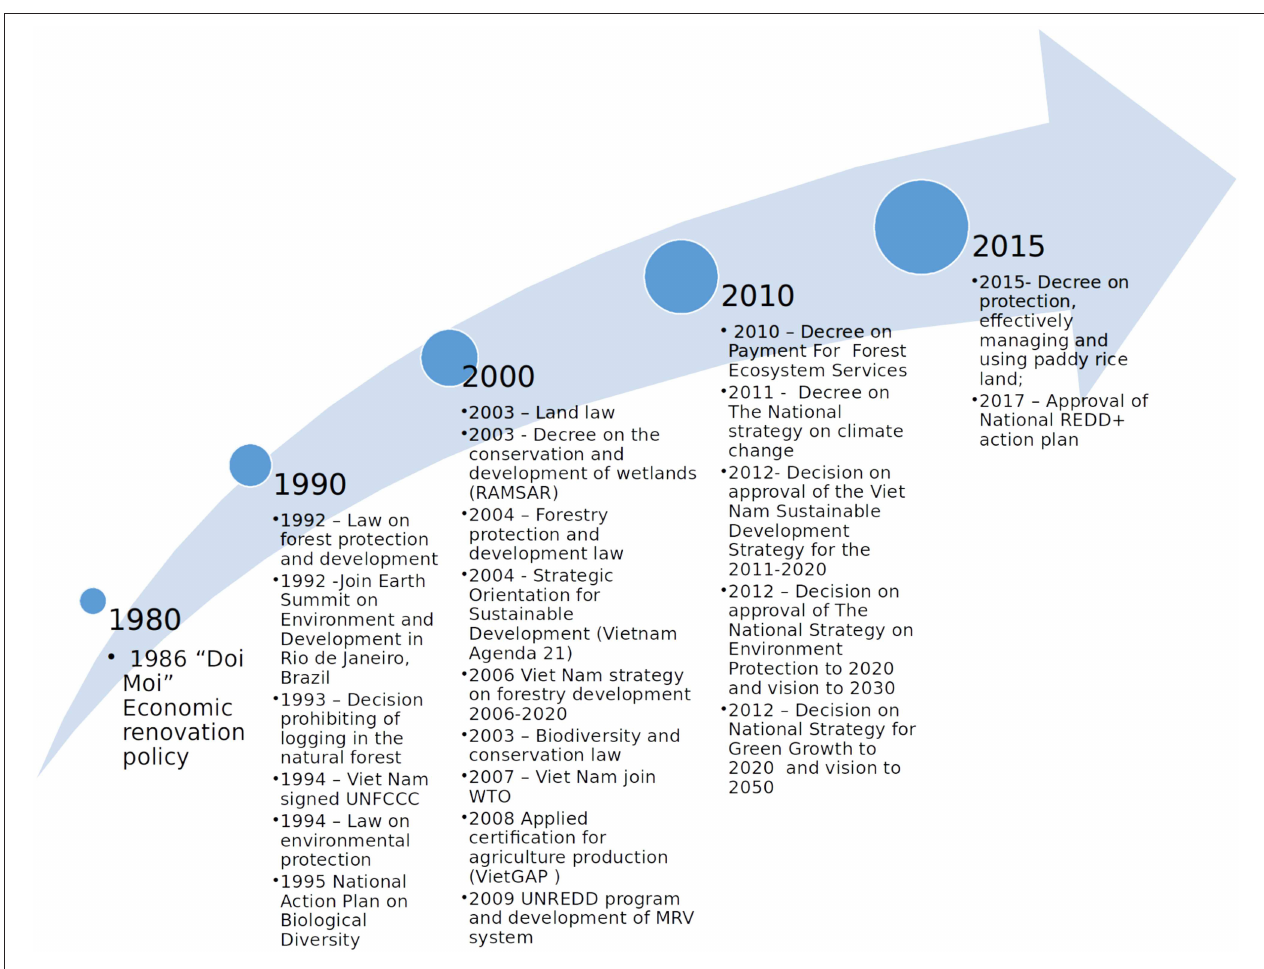
FIGURE 12 | Decadal environmental policy change timeline for